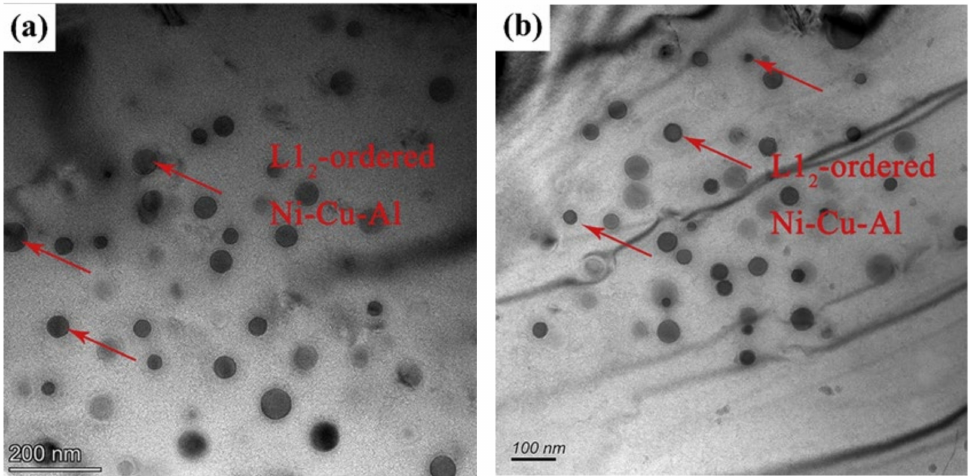
Figure 6. TEM micrograph of nanoscale L1 2 -ordered Ni-Cu-Al particles in ( a ) AFA and ( b ) AFA-W after aging at 700 ◦ C for 1000